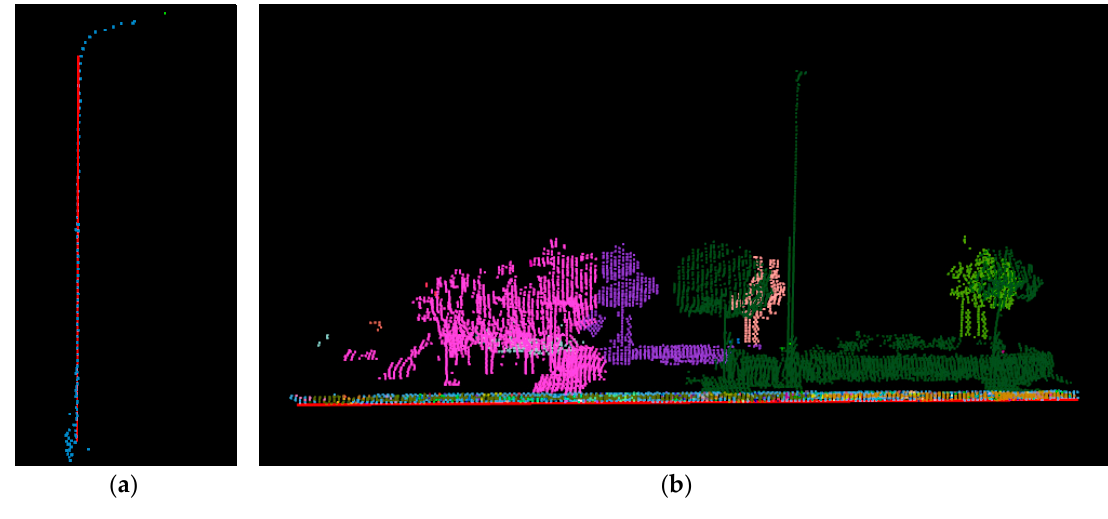
Figure 9. Line segments fitting for ( a ) pole-like objects and ( b ) curbs.